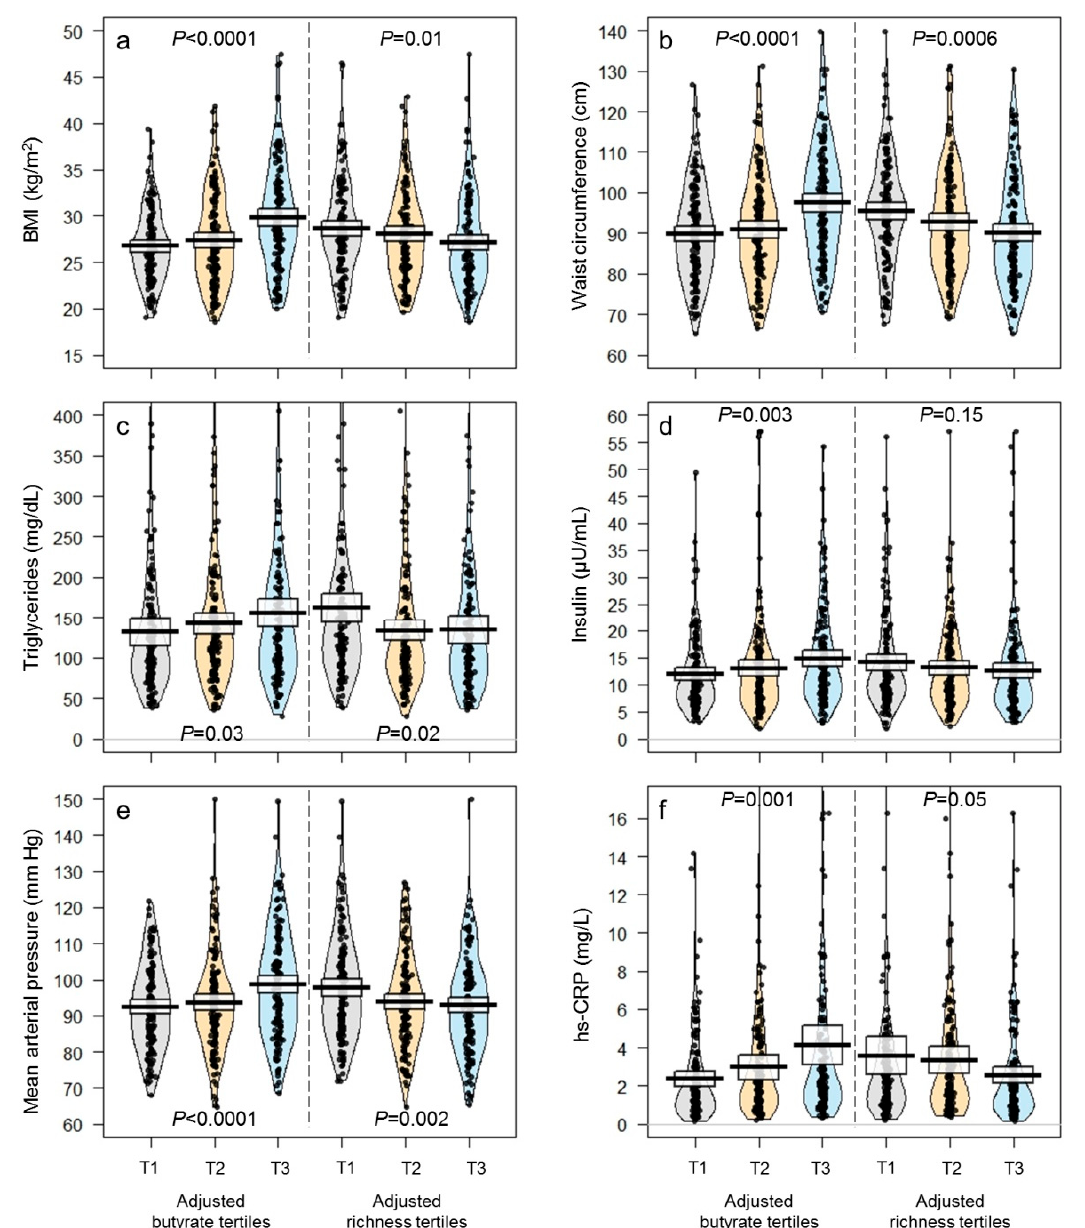
Figure 2. Distribution of various cardiometabolic health indicators according to tertiles (T1: Low, T2: Intermediate, T3: High) of multivariable-adjusted fecal butyrate concentrations (left) and microbiota diversity (right). ( a ) BMI; ( b ) waist circumference; ( c ) triglycerides; ( d ) fasting insulin; ( e ) blood pressure; and ( f ) hs-CRP. Values were adjusted for age, city of origin, caloric intake, physical activity, and fiber intake. The raw data, mean, and 95% confidence intervals are shown for each tertile.